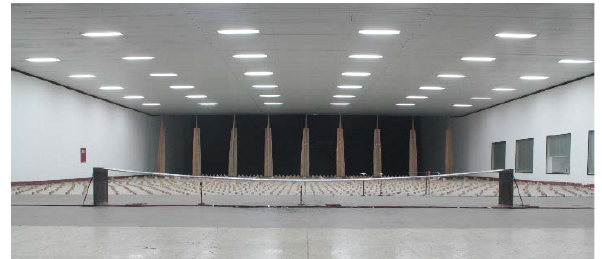
Figure 12. Taut strip model test conducted in XNJD-3 wind tunnel.